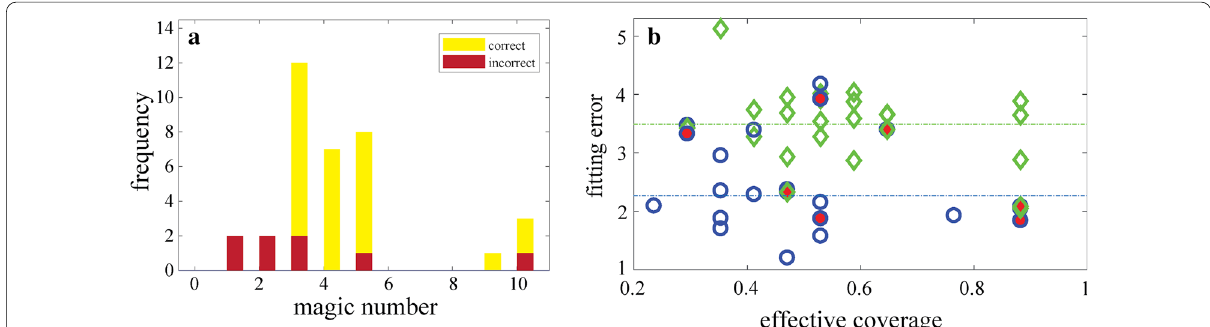
Fig. 8 Characterization of expert sampling strategies that were associated with a Type I error. a Frequency of expert magic numbers plotted by experts who made correct (yellow) and incorrect (red) conclusions. b Expert fitting error computed at the conclusion step. Blue circles represent individuals who received data supporting the given hypothesis and green diamonds represent individuals who received data supporting the alternative-unknown hypothesis. Filled markers represent individuals who made the wrong conclusion. The dashed lines of the corresponding colors show the representative fitting error for each